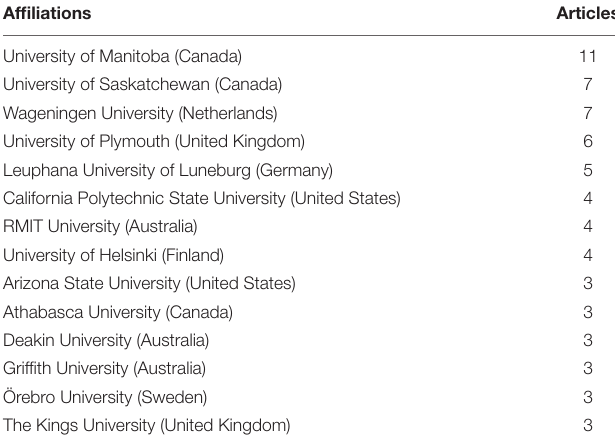
TABLE 3 | Main affiliations of published